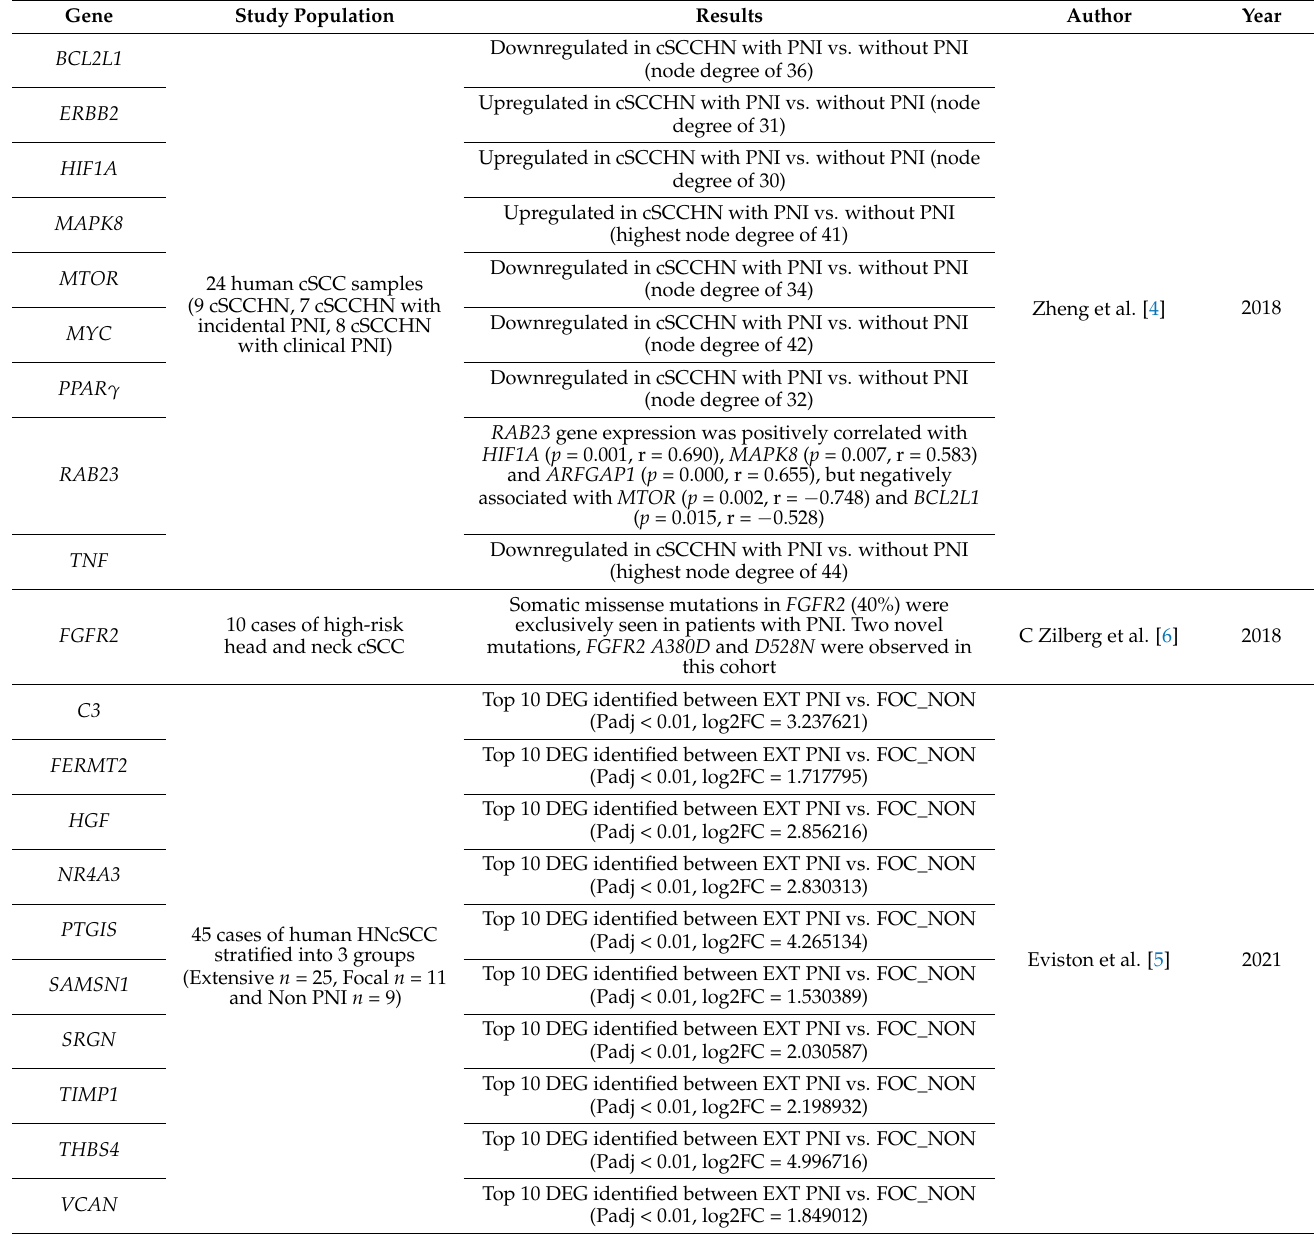
Table 1. Genes involved in perineural